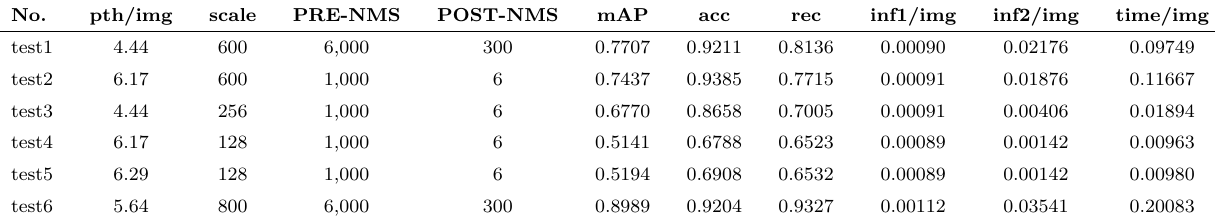
Table 5 Timing and performance. pth/img : average number of patches produced by an image. Numbers of proposals before and after NMS: PRE-NMS , POST-NMS . All inputs have a batch size of 24. The last three columns are inference time (in second) for BlockNet, the two-shot network and the whole pipeline = pth/img × inf2/img + inf1/img . Decreasing the number of proposals after NMS and zooming out the blocks result in a loss in performance, though earning more time. Increasing the sensitivity of BlockNet leads to a growth in the total number of blocks selected, eventually causing the whole network to slow down